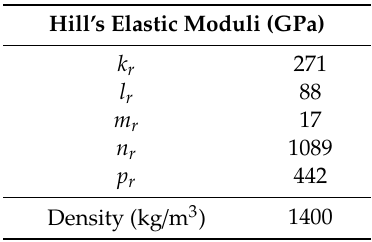
Table 2. Hill’s moduli of the SWCNT